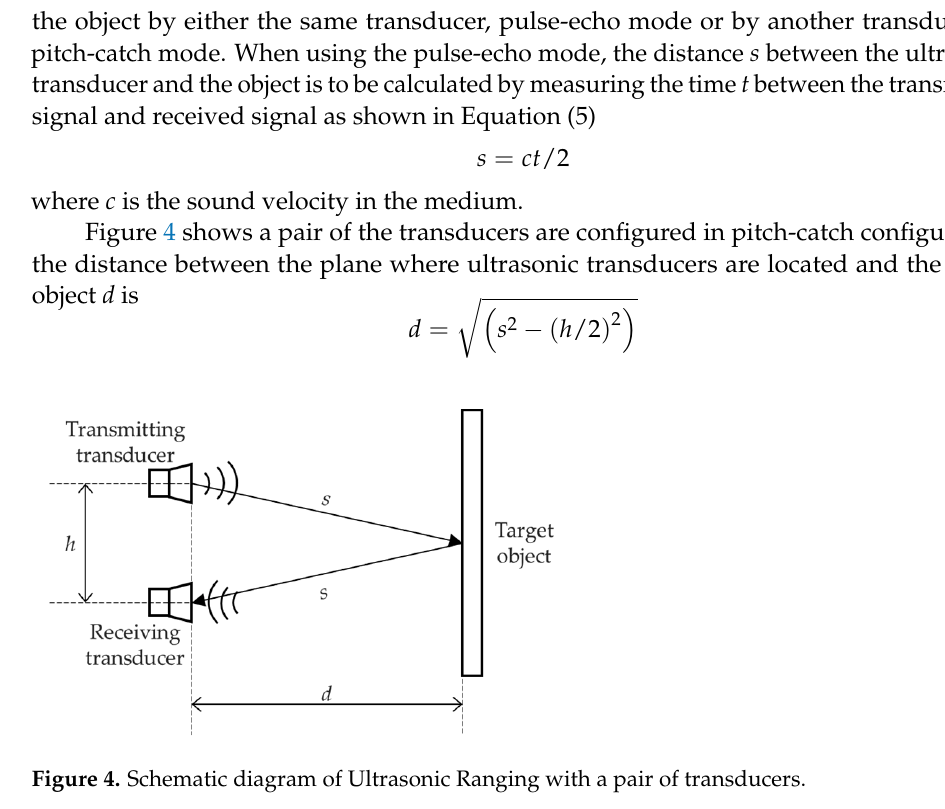
in this configuration.